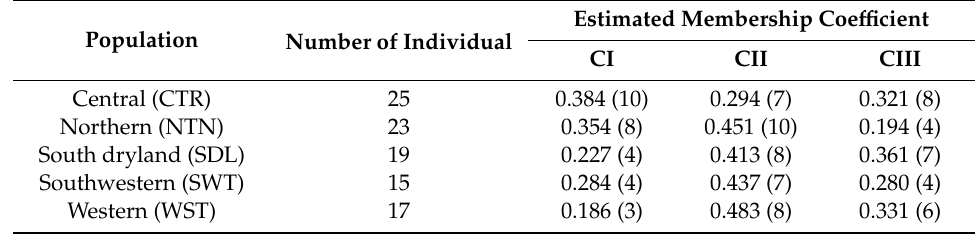
Table 3. Proportion of membership of each predefined population from structure analysis ( ∆ K =